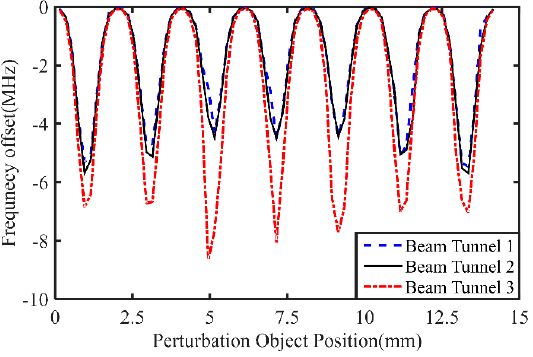
Figure 9. The frequency offset value shifts with the position of the perturbation object on the axis line, and the frequency offset curves of beam tunnels are shown in the figure.